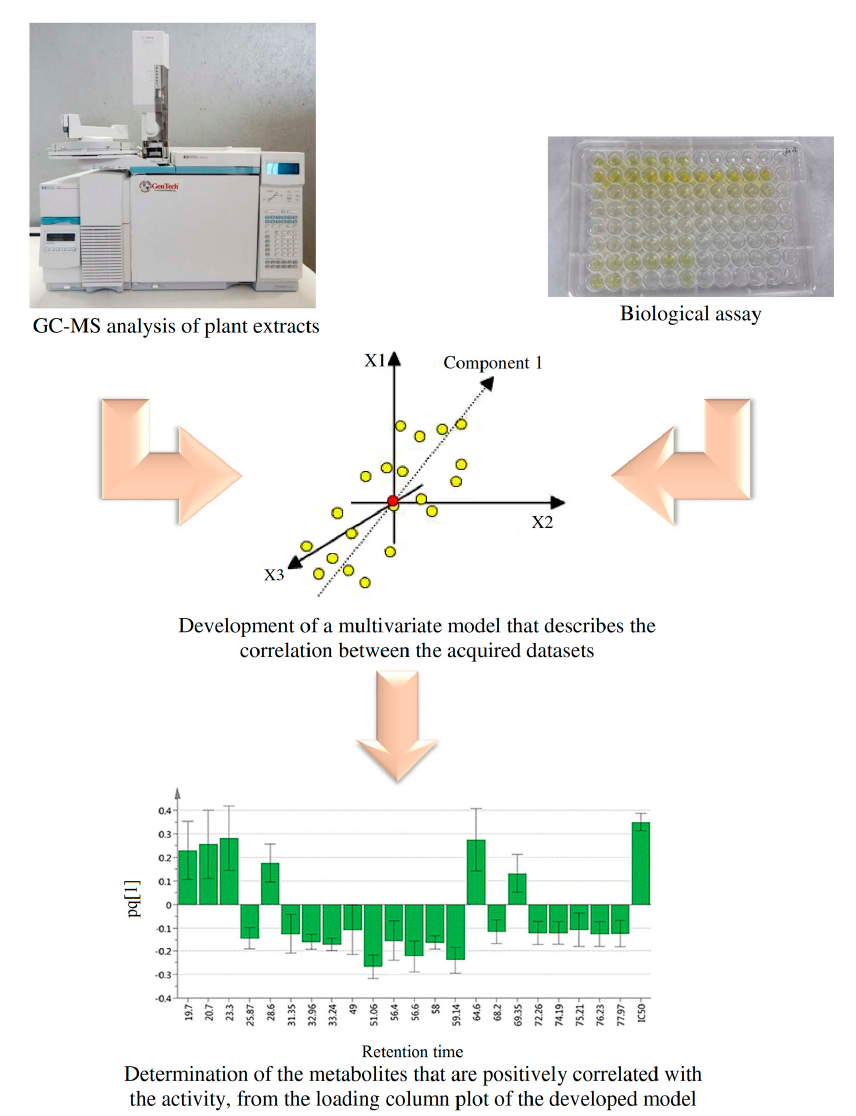
Figure 1. Typical procedure of the gas chromatography–mass spectrometry (GC–MS) metabolomics studies aiming to characterize the active plant